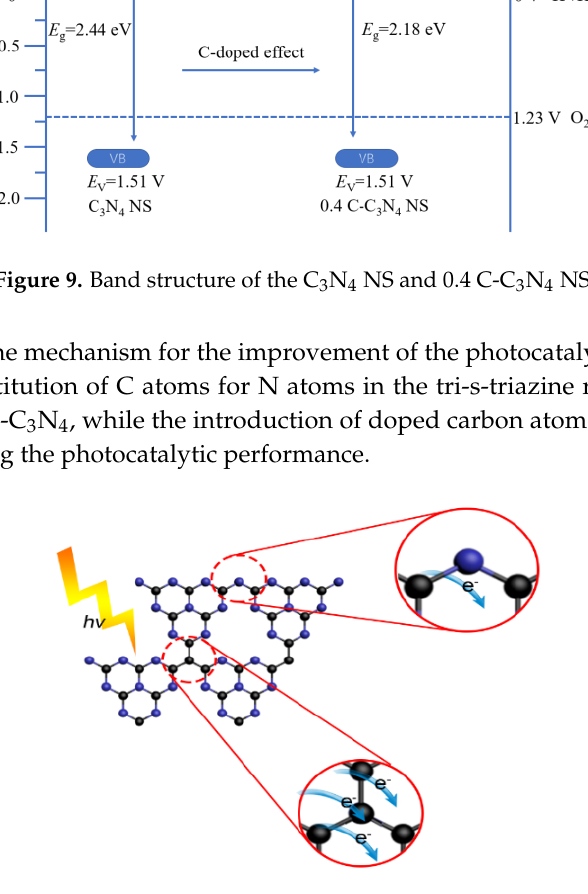
Figure 10. Mechanism of the photocatalysis performance improvement under visible light.